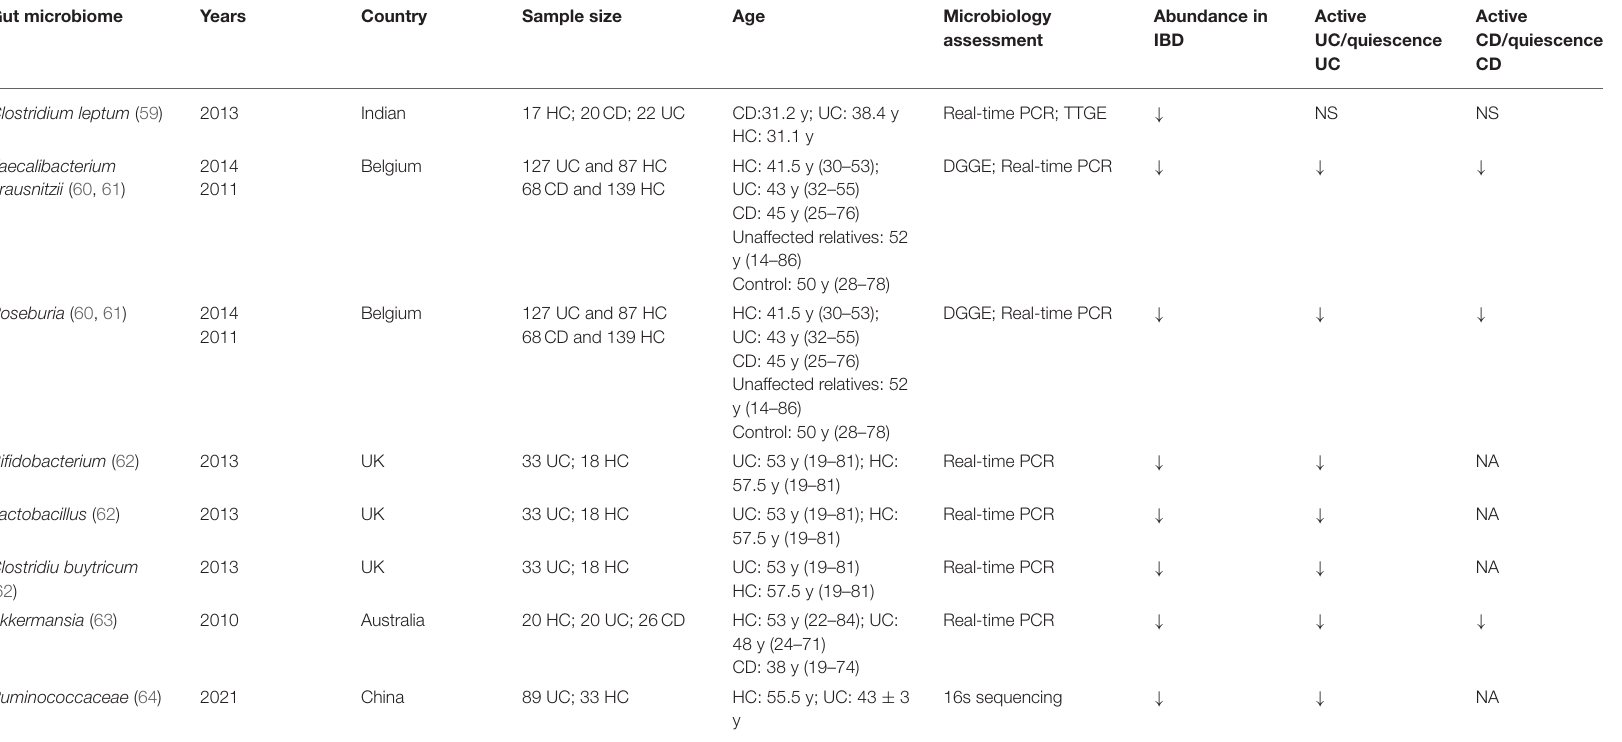
TABLE 2 | Changes in common intestinal bacteria in inflammatory bowel